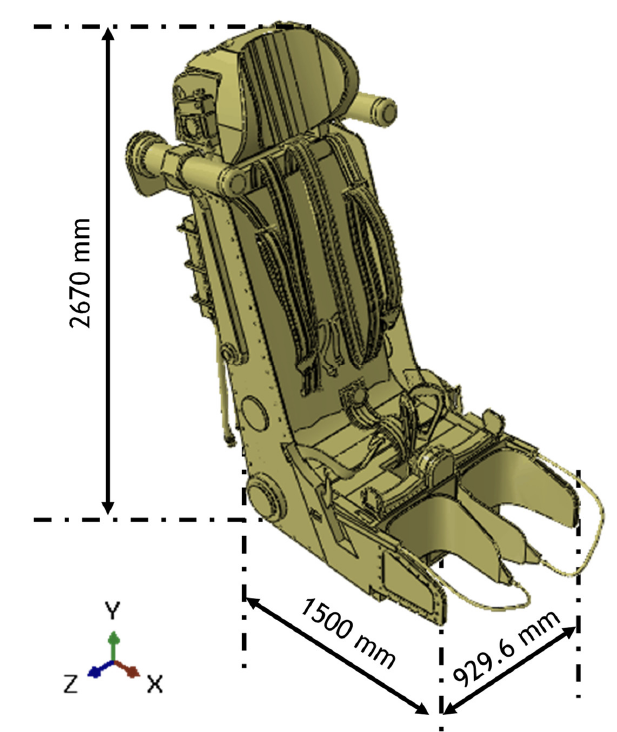
Figure 5. K-39 LT CAD model.